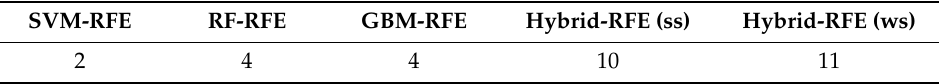
Table 4. Frequency of top accuracy for RFE methods.